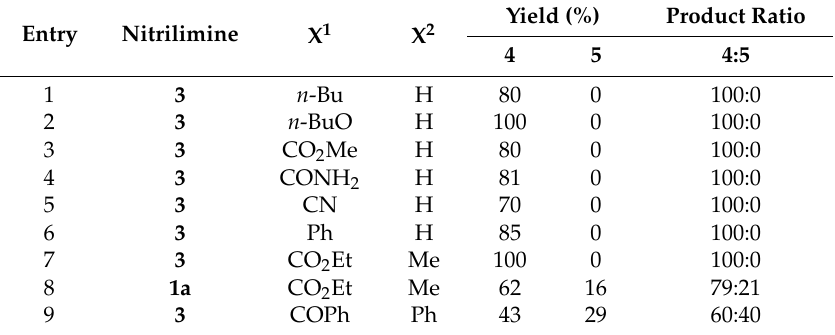
Scheme 2. Cycloaddition between nitrilimine 3 and mono- or disubstituted ethenes giving regioisomeric pyrazolines 4 and 5 . Table 2. Cycloaddition between nitrilimines 3 and 1a and mono- or disubstituted ethenes giving regioisomeric pyrazolines 4 and 5 (RG-II).